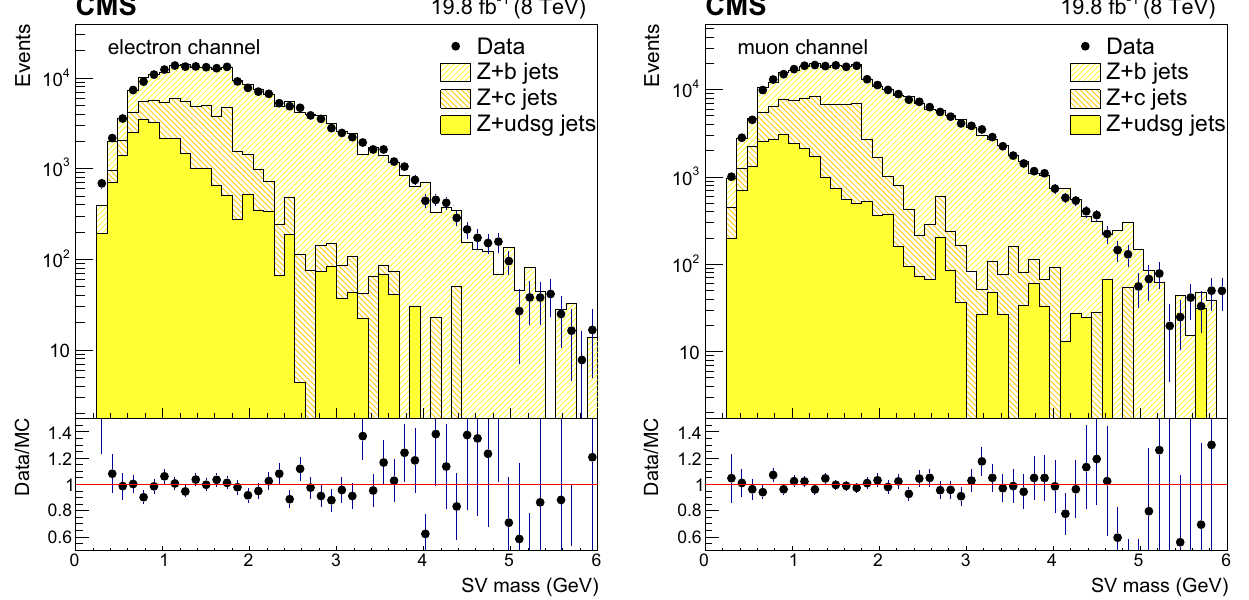
a fit to the secondary vertex mass distribution for dielectron and dimuon final states. The quoted uncertainties are statistical